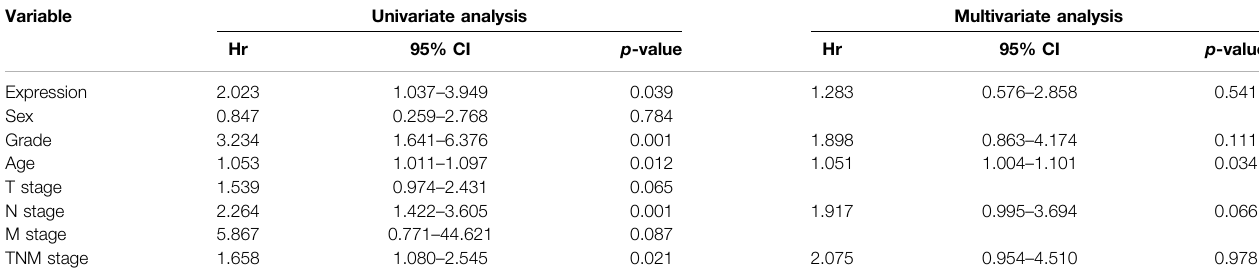
TABLE 3 | Univariate and multivariate analyses of the factors correlated with overall survival of lung carcinoma patients. Variable